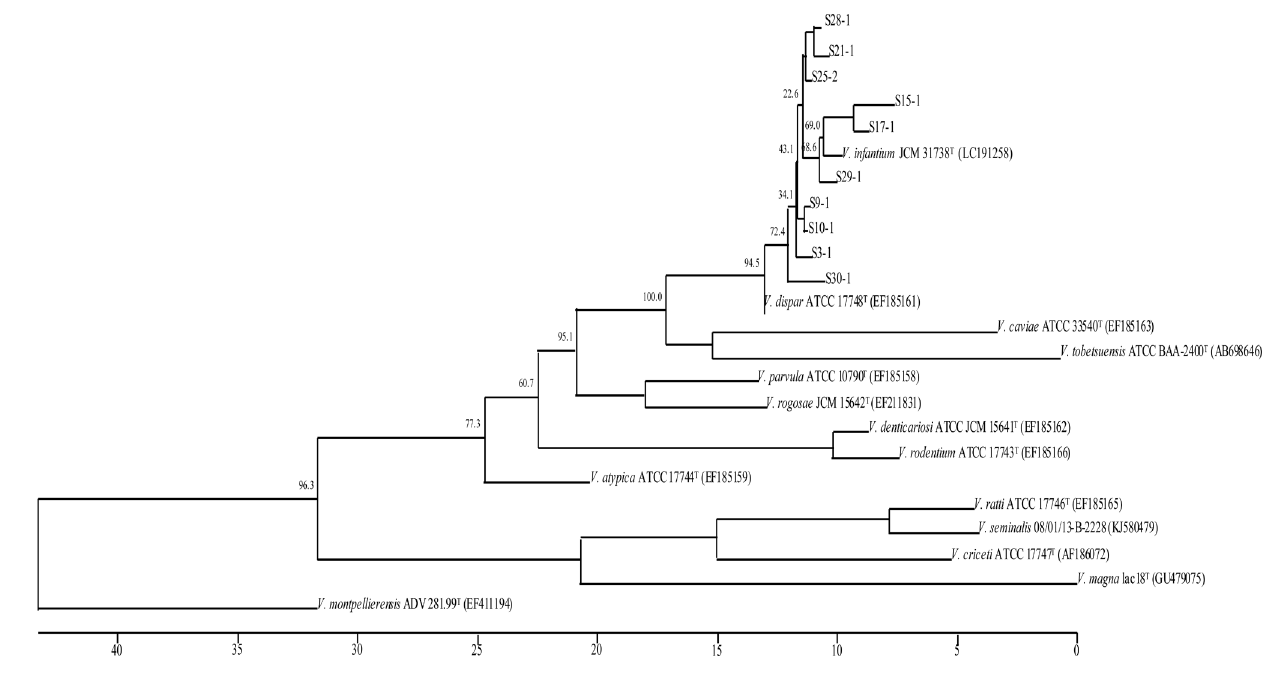
Figure 2. Neighbor-joining tree showing the relationship between the 10 unknown Veillonella strains and the type strains of established species of genus Veillonella , with accession numbers. Bootstrap values were indicated at corresponding nodes. The scale bar indicated the number of nucleotide substitutions per 100